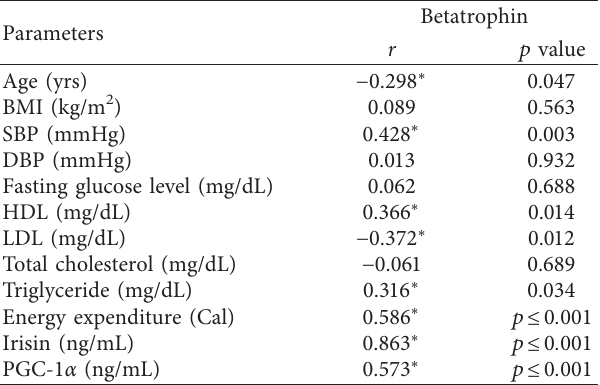
Table 2: Univariate correlations with plasma betatrophin in all participants.